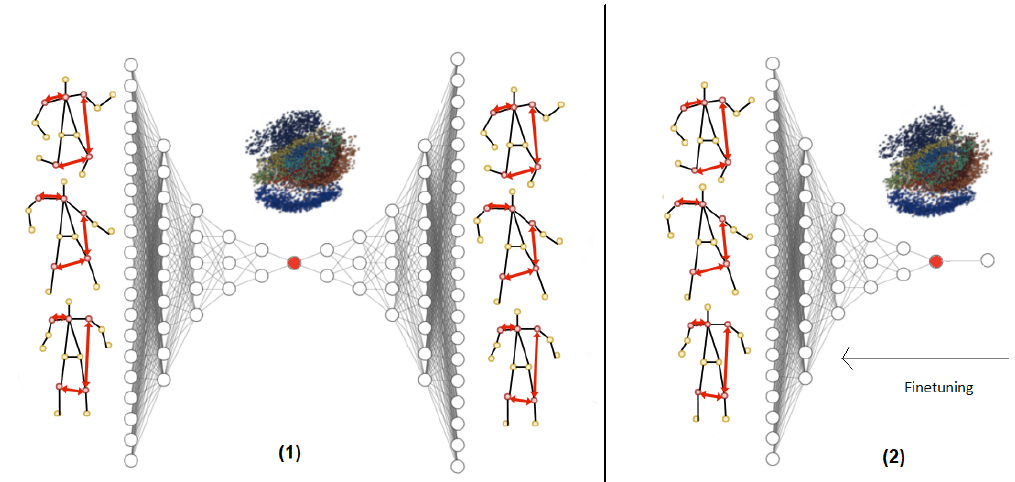
Figure 5. Pipeline of the approach for the Geometric branch: ( 1 ) we train an auto-encoder to reconstruct a sequence representing an action according to the evolution over time of the distances (represented by the red arrows) of selected keypoints (Torso, Left and Right Shoulders, Left and Right Knees). We also add a constraint specific to the separability of classes in the latent space. ( 2 ) We then extract the weights of the encoder part up to the bottleneck represented in red and add a classifier, which transforms the encoder part into a pre-trained network on the data for action